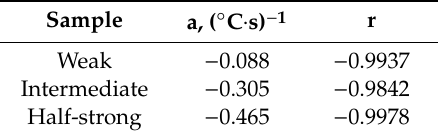
Table 1. Slopes a and Pearson correlation coe ffi cients r from the linear Equation (5) for the weak, intermediate, and half-strong black liquors.